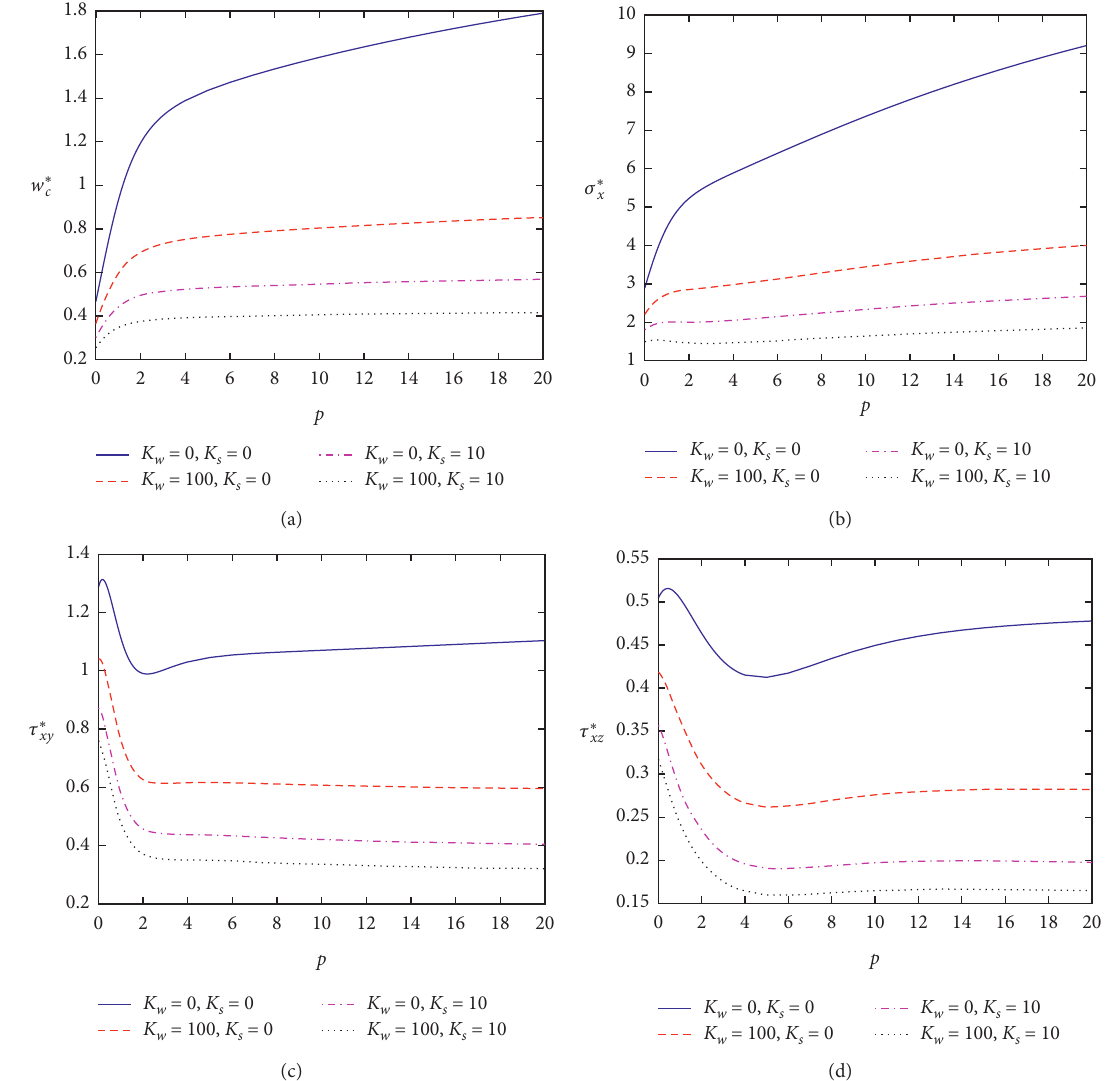
Figure 2: The variation of deflection and stresses as the functions of the power-law